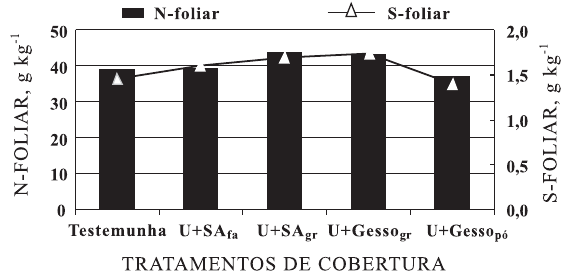
Figura 5. Teor de N e S-foliar, 30 dias após efetuada a adubação em cobertura, na cultura de milho na safra 2005/2006. Uberlândia (MG).